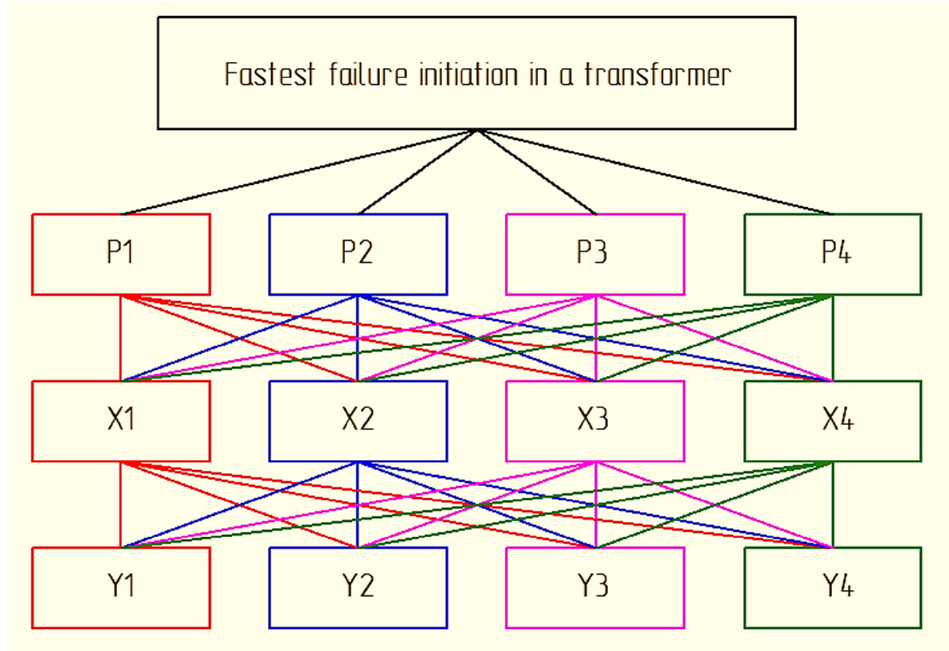
Figure 3. Hierarchical model of fault reasons and symptoms for an oil-filled transformer. The fourth (lower) level of the hierarchy involves the key symptoms of failures for an oil-filled power transformer: Y 1 —winding overheating; Y 2 —winding